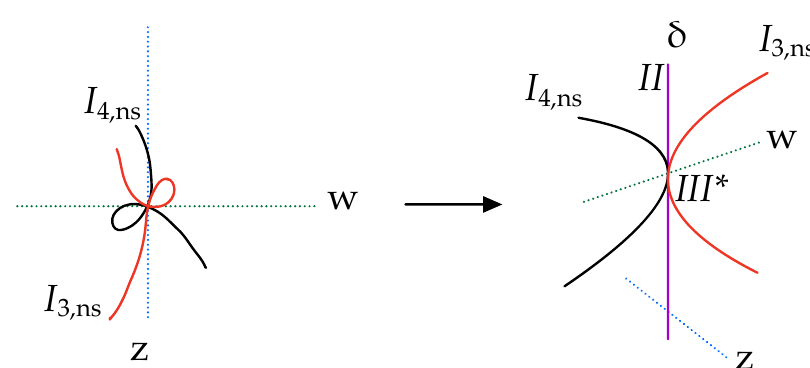
Figure 3: Before the base blow-up there are two self-intersecting divisors intersect at w = z = 0. After the base blow-up at w = z = 0 the w = 0 line and the z = 0 line are separated by the compact curve δ = 0 on the base over which there is a type I I elliptic fibration except at the point δ = w =